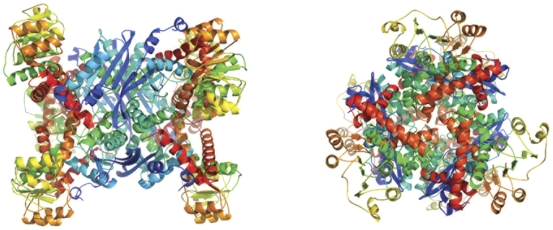
GDH hexamer from E. coli.The protein forms a hexamer (dimer of trimers). Left, view of the GDH hexamer along the two-fold axis. Right, view of the GDH hexamer along the three-fold axis.